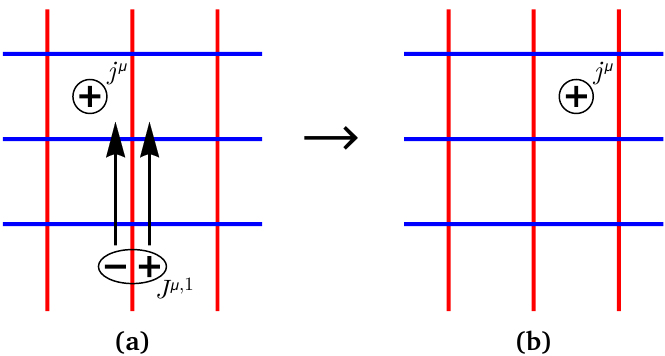
Figure 3: A 2D slice of 3D space showing two foliations (red and blue). (a) When in isolation, a charge (sourced by j µ ) cannot move through a foliation layer, which results in the mobility constraints tabulated in Tab. 1. However, a dipole J µ 1 can move along a red layer and be absorbed by the charge to move the charge to the right, as depicted in (b)